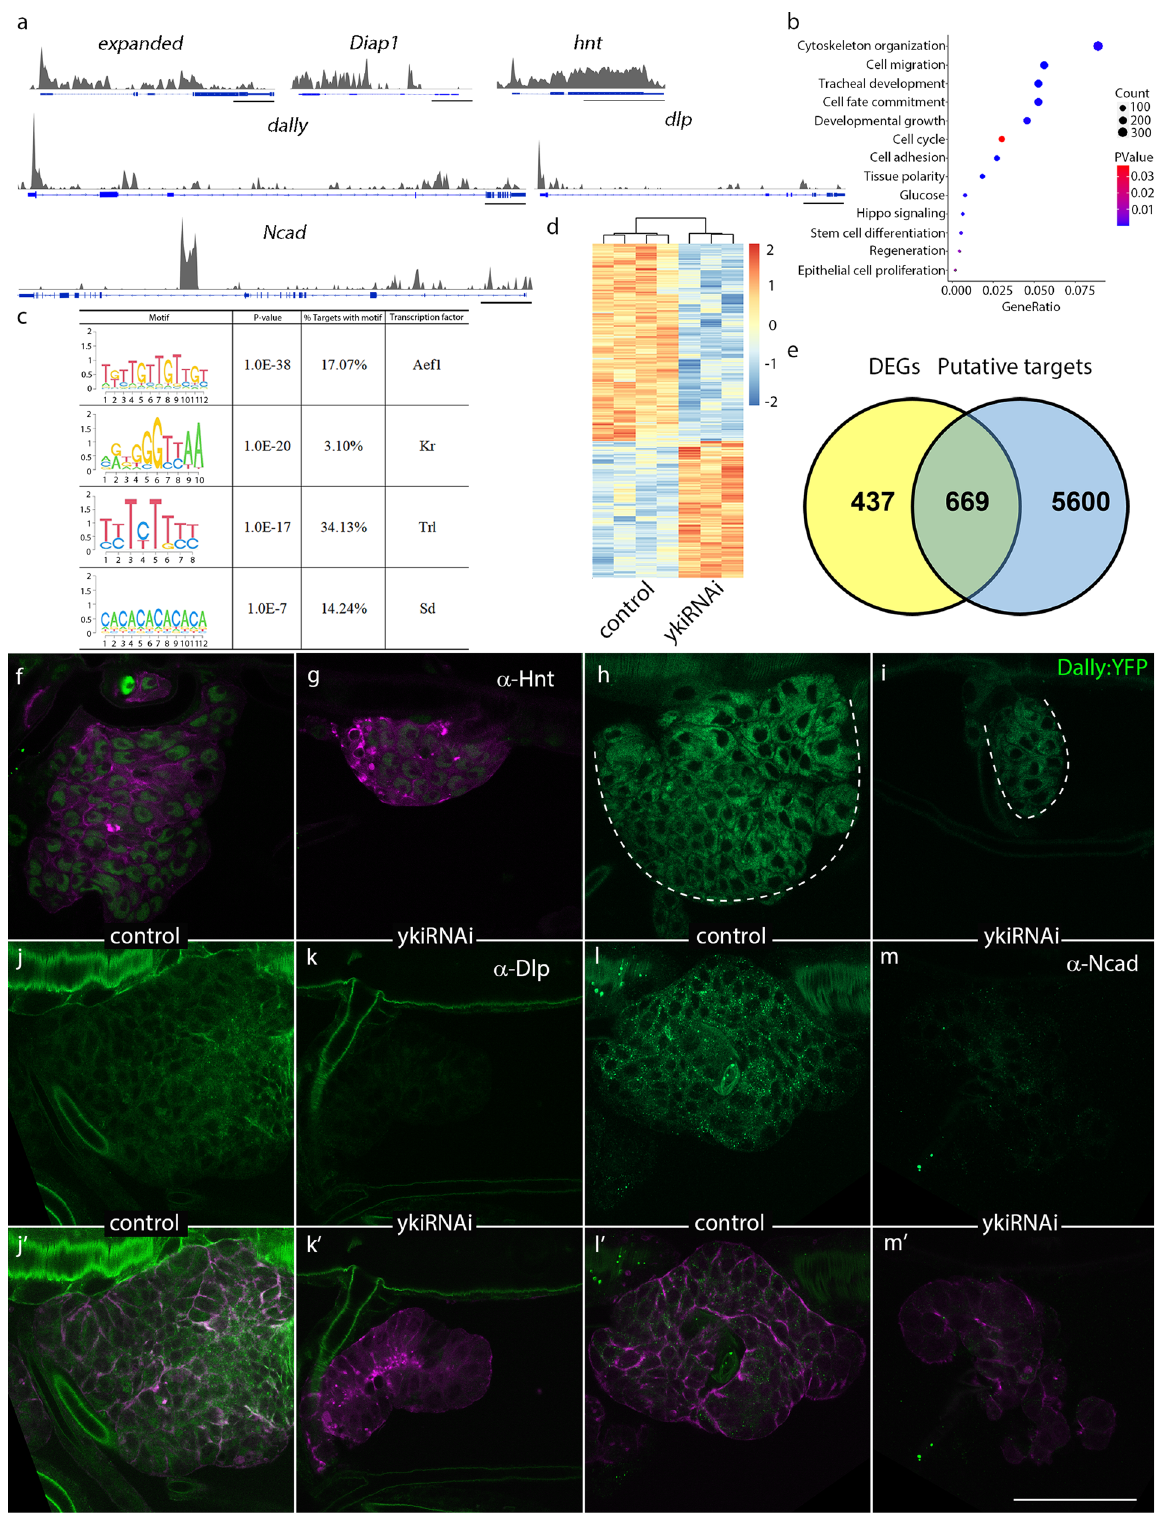
25 °C for 5-hour starvation. The larvae were starved on fi lter paper (Ø10mm) soaked with distilled water. Gal80 ts inactivation . The expression of btl-Gal4 was restricted by temperature sensitive tub-Gal80 ts . Larvae expressing UAS-InR DN , UAS-Akt , UAS-AktRNAi , UAS-ykiRNAi or UAS-HntRNAi were raised at 18°C and then were shifted to